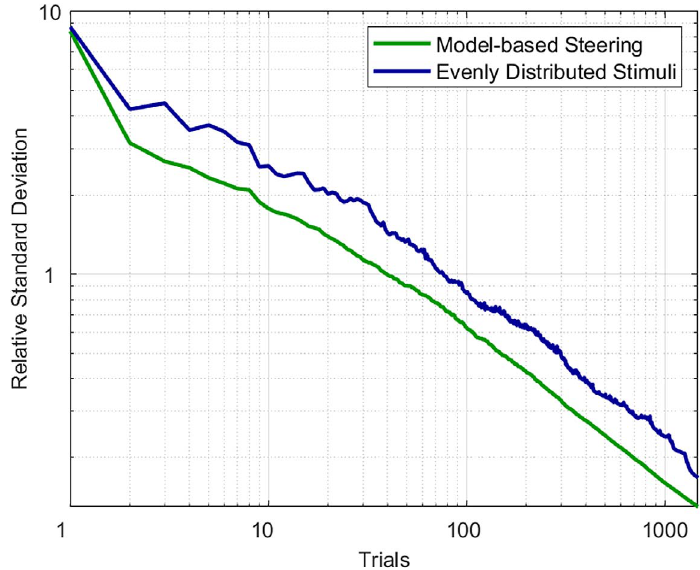
Figure 7. Mean relative standard deviation of the three model parameters as a function of trial